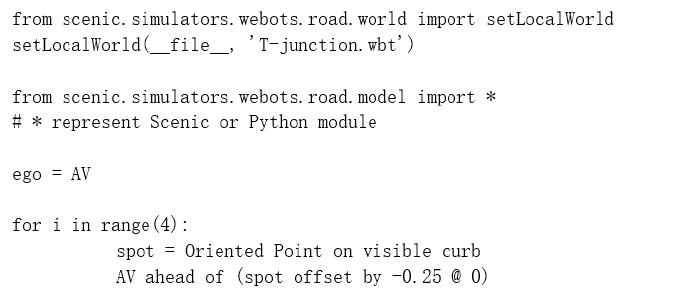
Figure 11. Example scenario in